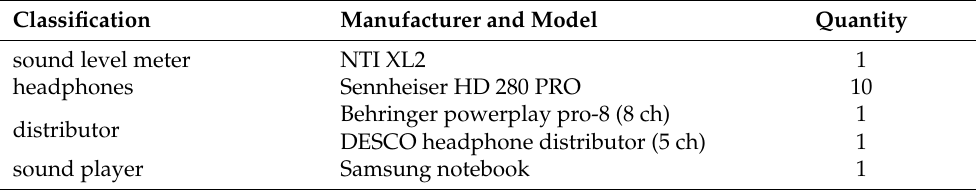
Table 11. List of equipment used for the speech intelligibility